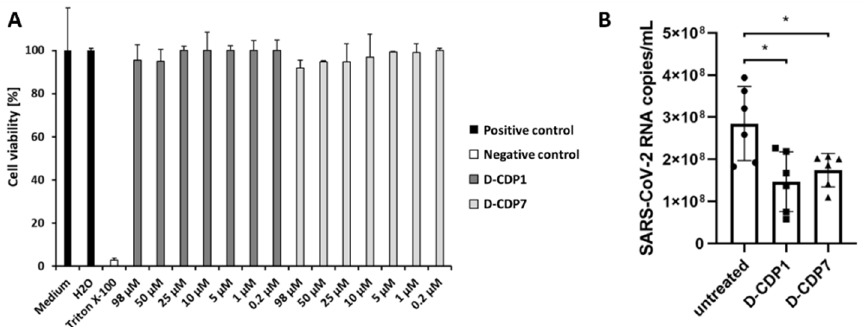
Figure 6. MTT assay and inhibition of SARS-CoV-2 by D-CDP1 and D-CDP7. ( A ): MTT assay of D-CDP1 and D-CDP7 on Vero CCL-81 cells. MTT assay was used to evaluate the cytotoxicity of the two D-peptides. Different concentrations of up to 98 µ M were used to treat the Vero cells for 2 days. Data shown are the means ± SD from three independent measurements ( n = 3). ( B ): Inhibition of SARS-CoV-2 by D-CDP1 and D-CDP7. Vero cells were treated with 50 µ M of either D-CDP1 or D-CDP7, and after an hour of incubation, the cells were infected with SARS-CoV-2 using a multiplicity of infection (MOI) of 0.05. Untreated cells were used as control. Viral RNA in the supernatant was analysed in-house. The statistical significance of the mean values’ differences was assessed with a standard two-tailed unpaired t -test (demonstrated by asterisks). The graph shows individual data points with mean ± SD ( n =